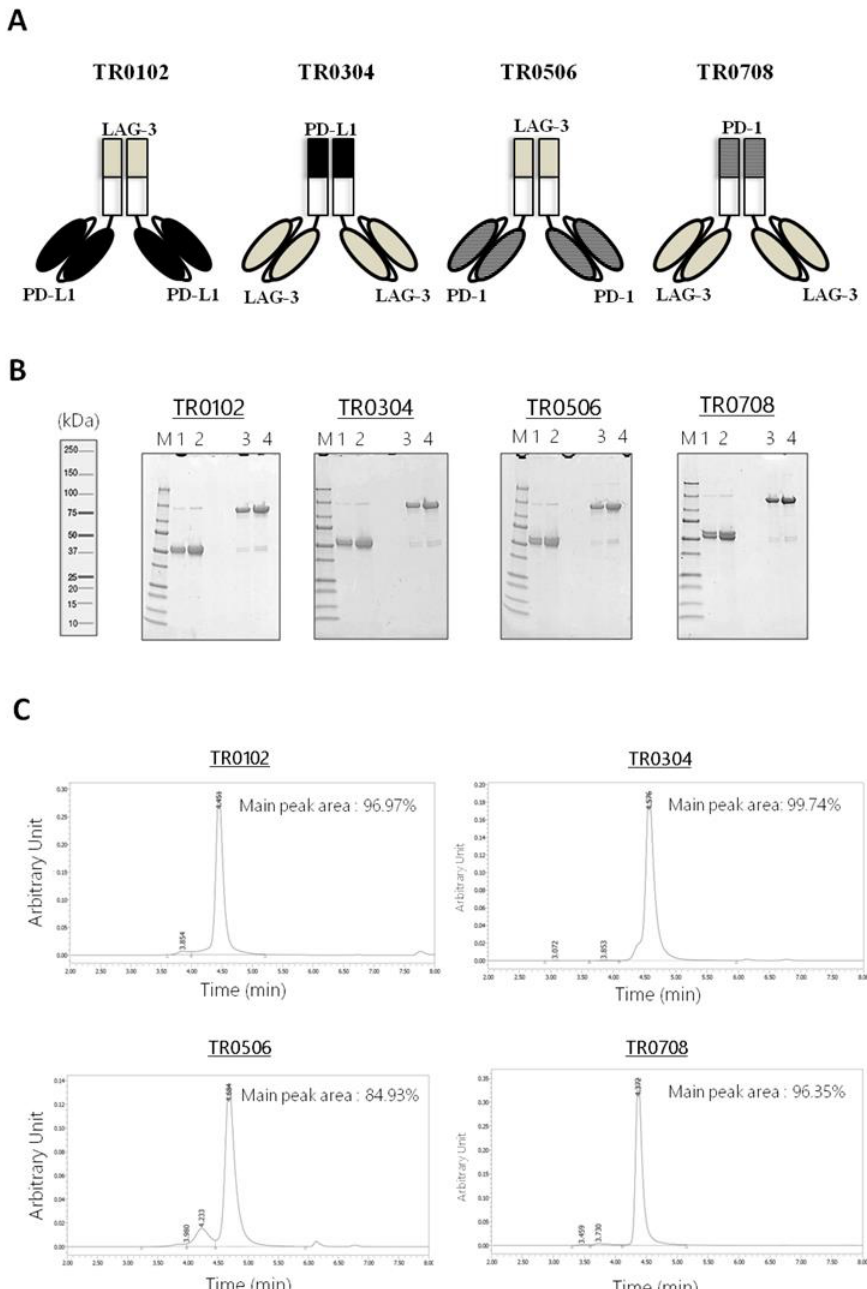
Figure 2. Schematic representation and purification of bispecific tribodies targeting LAG-3 and PD-L1 or PD-1, derived from LAG-3_1, PD-L1_1 and PD-1_1 parental mAbs. ( A ) Each TR was obtained by genetically fusing the indicated Fab with two identical scFvs. ( B ) Analysis of purity of the tribodies. Coomassie Blue stained SDS-PAGE of His-tagged Tribodies under reducing (lanes 1 and 2) or nonreducing conditions (lanes 3 and 4) obtained after purification by Ni-affinity chromatography. ( C ) SEC analysis of the final products to confirm the